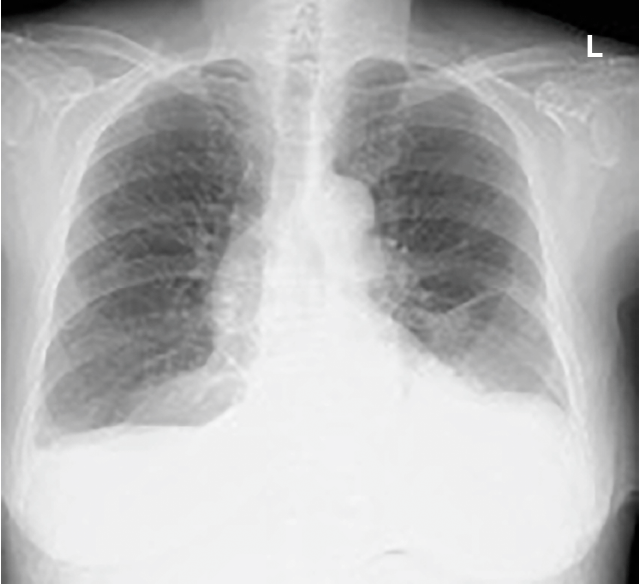
Figure 6. The day before hospital discharge. Mediastinal and subcutaneous emphysema had im-